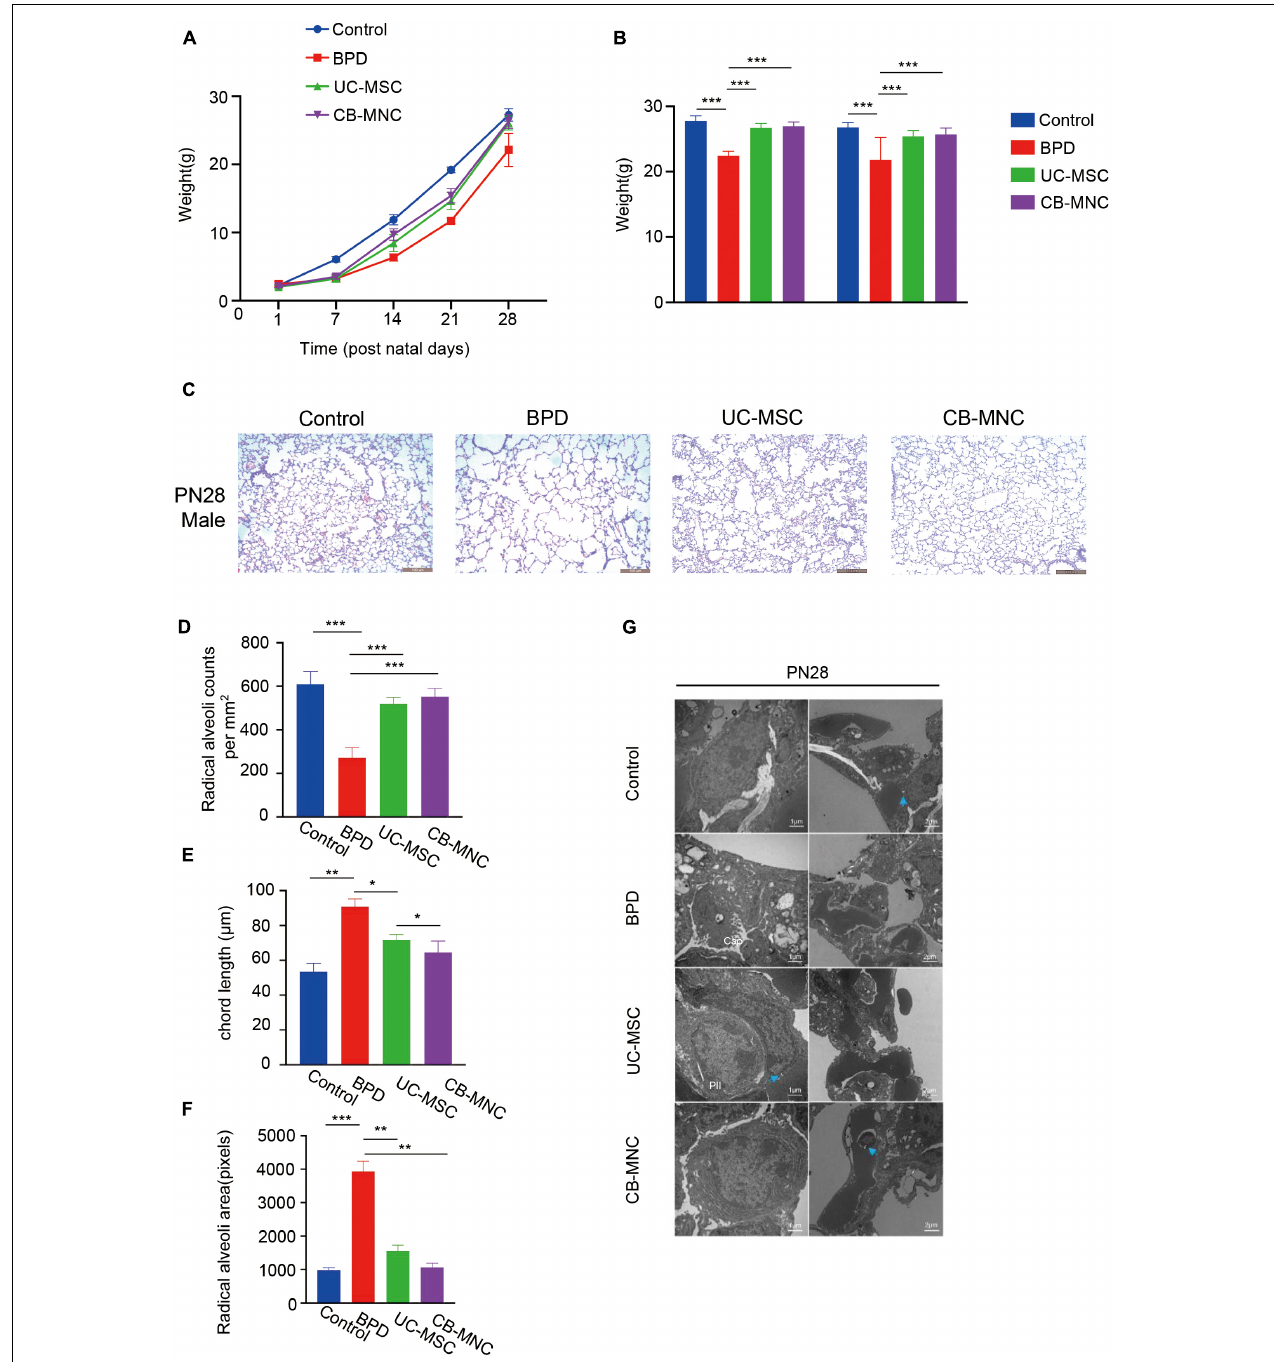
FIGURE 3 | Intravenous infusion of cord blood-derived mononuclear cells (CB-MNCs) and umbilical cord-derived mesenchymal stem cells (UC-MSCs) improves hyperoxia-induced bronchopulmonary dysplasia (BPD). (A) Line graph illustrating the changes of weight in mice with different treatments at indicated time points. (B) Bar graph illustrating the change of weight in male and female mice with different treatments at postnatal day (PN)28. (C) Representative H&E staining images of lung histology in hyperoxia-exposed male mice with indicated treatments at PN28. Scale bar: 100 µ m. (D–F) Sections of whole lungs were analyzed for the number of alveoli per square millimeter (D) , the chord length (E) , the size of the alveoli (F) . (G) Electron microscopy presenting the distal lung architecture of hyperoxia-exposed preterm mice subjected to different treatments at indicated time points. Pictures in left orientation indicated the type II pneumocytes, scale bar: 1 µ m, whereas pictures in right orientation indicated the capillaries, scale bar: 2 µ m. Values are mean ± SD of a minimum of six animals in each group, *p < 0.05, **p < 0.01, ***p < 0.001, by one-way ANOVA test. Data are representative of three independent biological replicates.